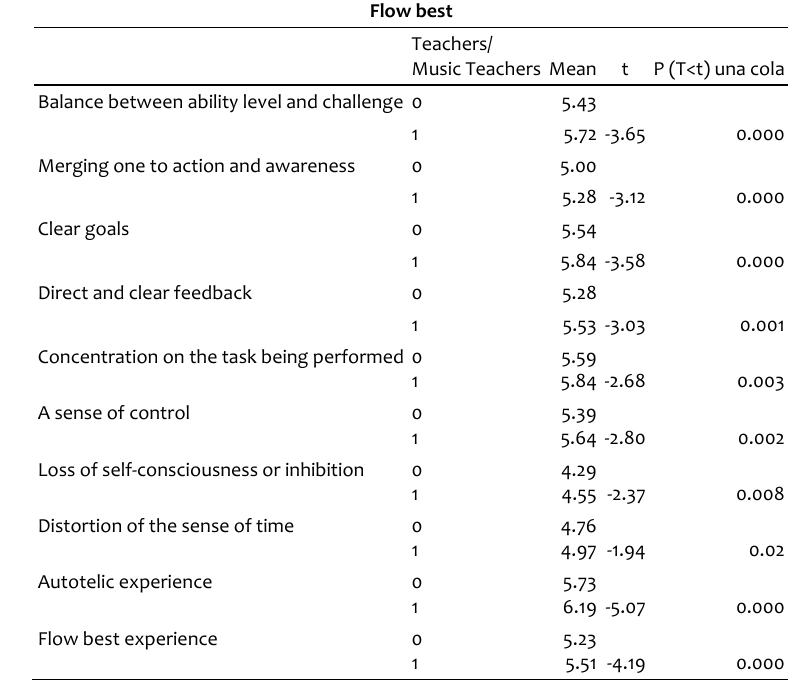
Table 6. t ‐ Test for Flow State for best